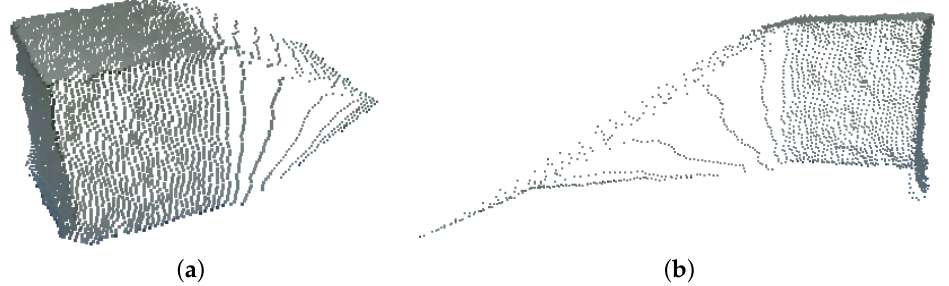
Figure 23. Noise distribution obtained with Kinect V2 in the acquisition of the cubes. (a) Perspective view; (b) Side view.